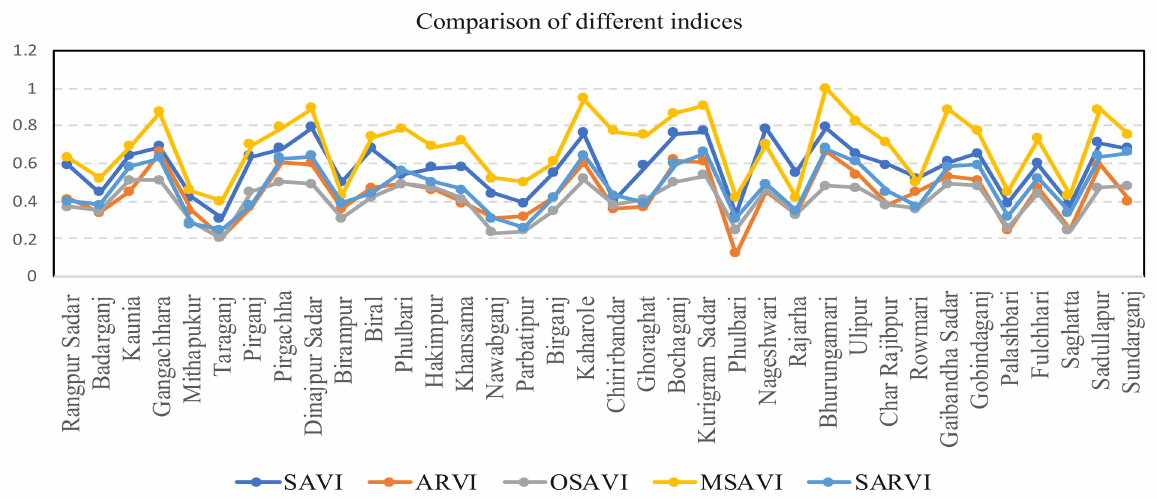
Figure 5. Comparison of different indices and ground reference information points in 36